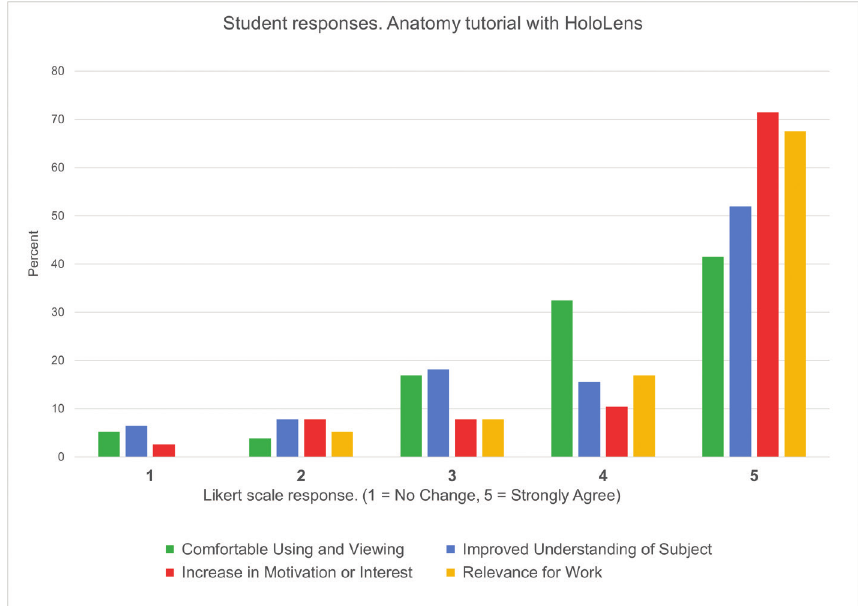
Figure 5. Student survey results from a scale of 1 on the left (no change) through to 5 on the right (strongly